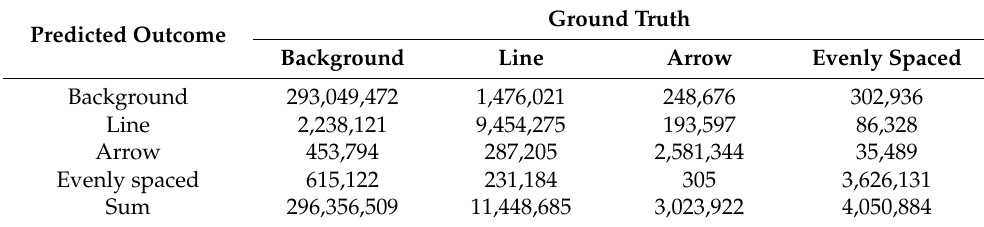
Table 4. The confusion matrix of the multi-label semantic segmentation model. Predicted Outcome